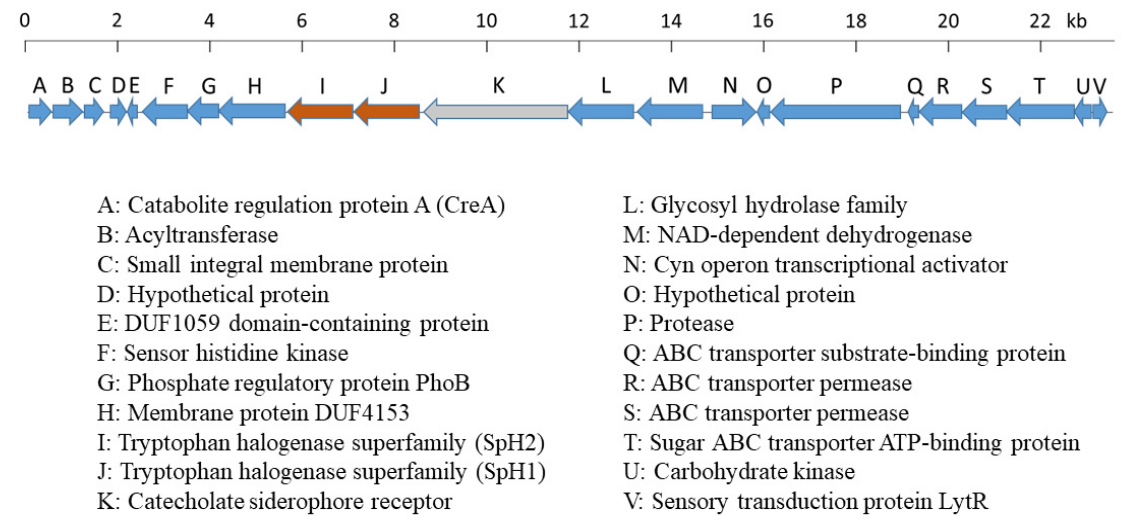
Figure 2. Gene cluster in the vicinity of hit 21 (J; SpH1) in the metagenome-assembled genome (MAG) 21 of the B. braunii bacterial consortia. Another flavin-dependent halogenase gene, sph2 (J), was identified upstream to sph1 (I). The genes I, J, K, and L were found to be encoded on the same contig in the metagenomics dataset.